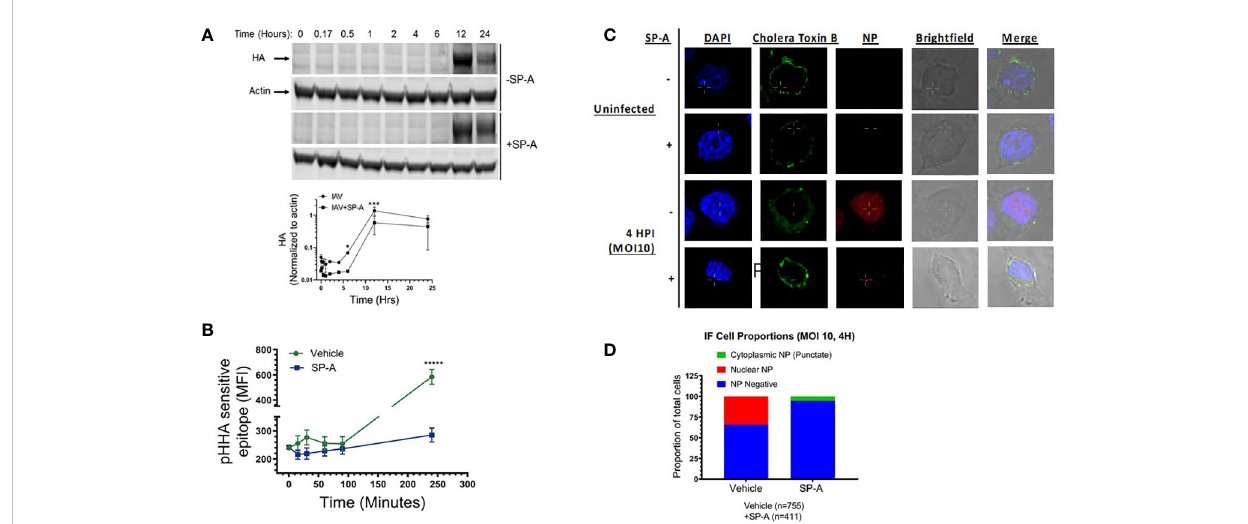
FIGURE 3 SP-A delays IAV infection at endosomal level. (A) SP-A delays synthesis of HA. RAW264.7 cells were treated with SP-A for fi ve hours and then infected with IAV at MOI=15. Cells were harvested 1, 2, 4, 6, 12, and 24-hours after infection to obtain cell extracts for Western blot analysis using